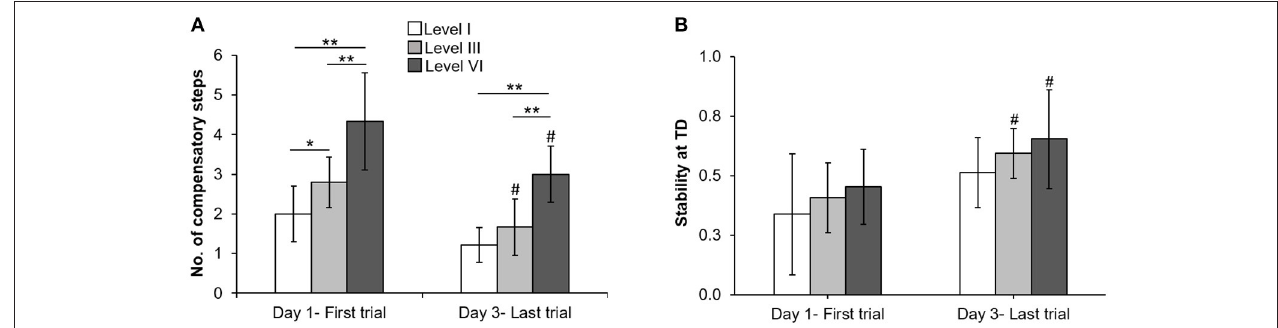
FIGURE 3 | Changes in mean ( SD) (A) number of compensatory steps after perturbation onset and (B) COM state stability at compensatory step touchdown (TD) at ± lowest (level I), mid (level III), and highest (VI) perturbation intensities between first training trial on day 1 and last training trial on day 3. * p < 0.05 and ** p < 0.01 indicates significant differences between different perturbation intensities on the same day and # p < 0.05 indicates significant differences between same intensities on first (day 1) and last day (day 3).